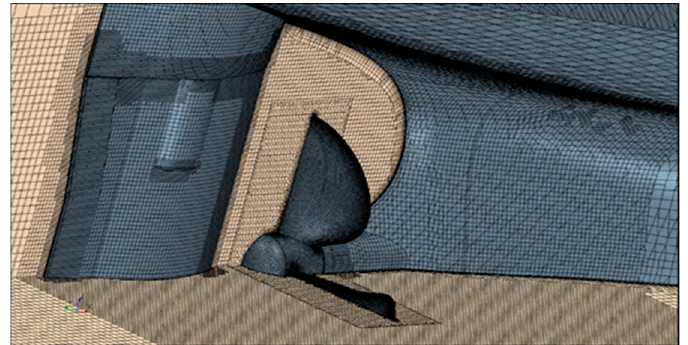
Figure 1. Fragment of computation mesh in the vessel stern region.